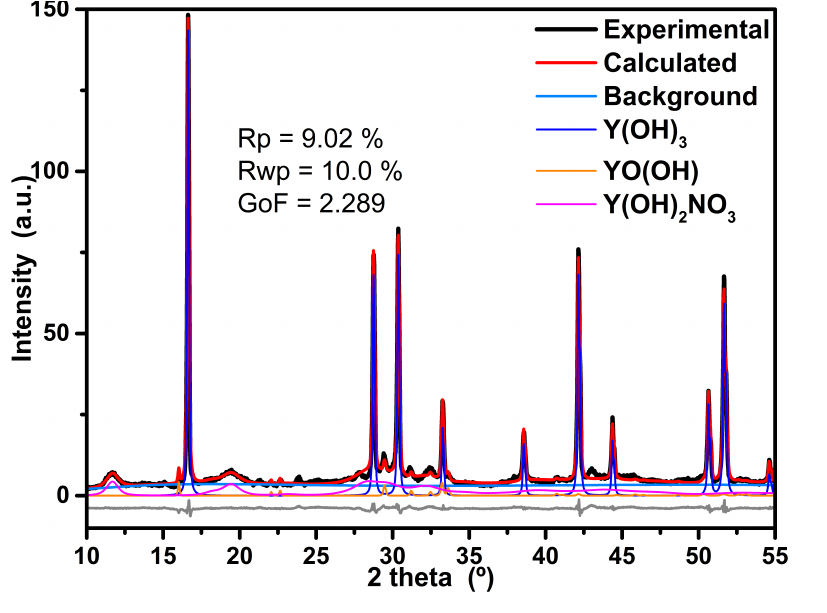
Figure 4 Results of refinement of the sample prepared at 4 h. Results of refinement of the sample pre- pared at 4 h; in order to be appreciate the fit, only data between 25 and 65 2 theta are displayed, the back- ground component as well as the difference between experimental and calculated data are also